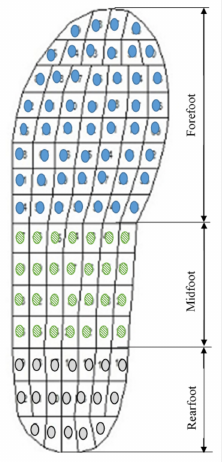
Figure 1. Plantar anatomic region divided into three